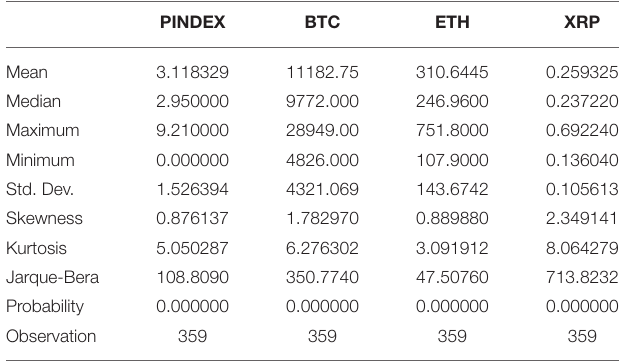
TABLE 1 | Descriptive statistics.